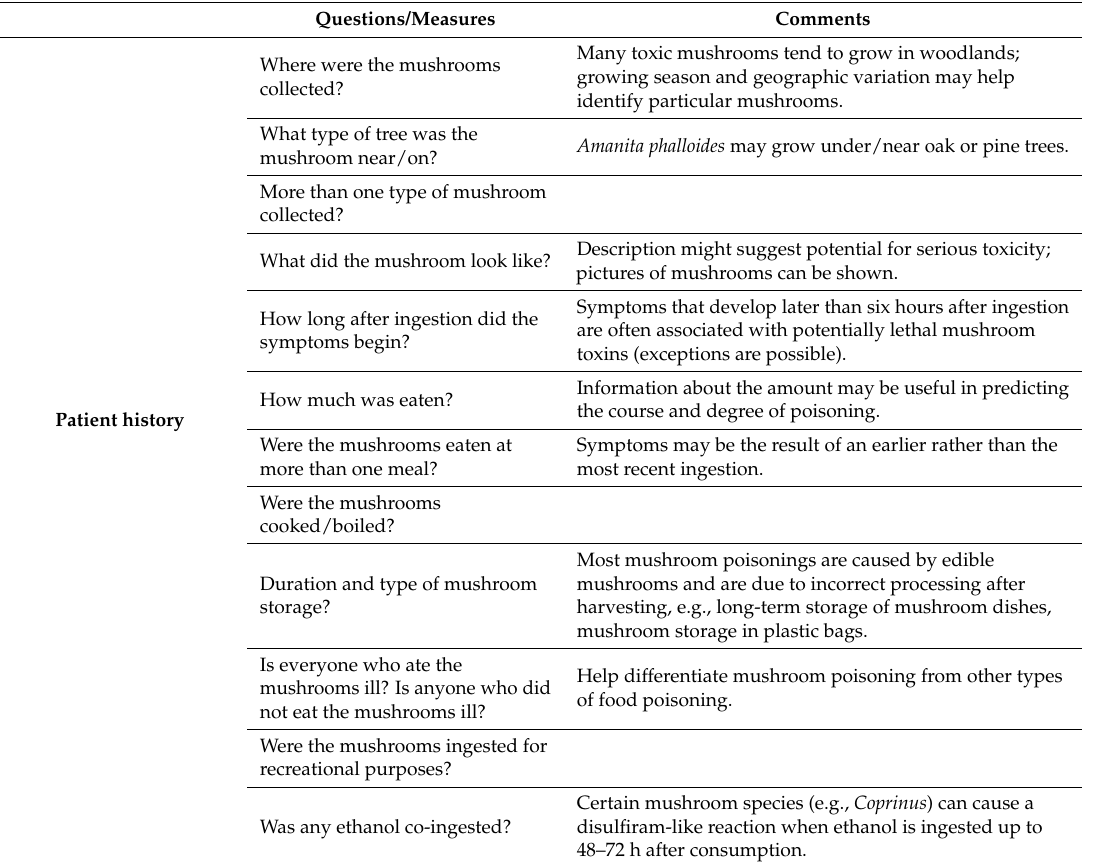
Table A1. Checklist of management in cases of (suspected) mushroom poisoning (data from